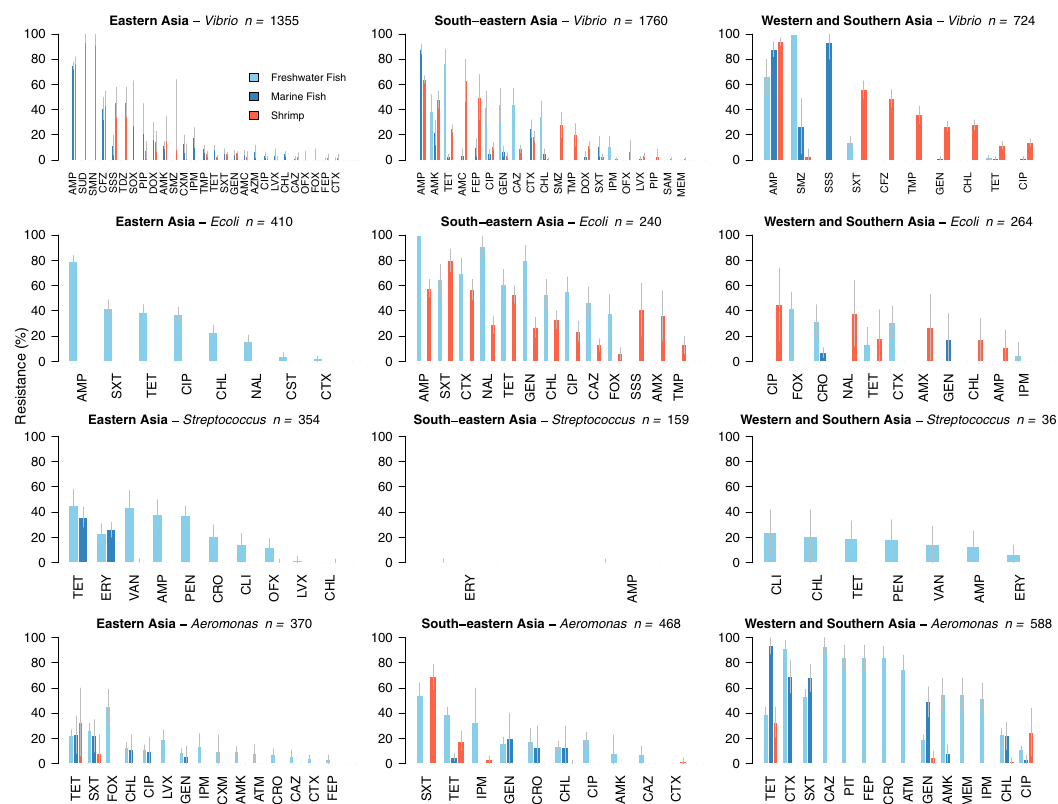
Fig. 2 Antimicrobial resistance in foodborne pathogens isolated from aquatic animals in Asia. Gray bars represent 95% proportion con fi dence intervals. Resistance is shown for pathogen-drug combinations recommended for susceptibility testing (Supplementary Table S1) and with 10 or more isolates tested. (For drug acronyms, see Supplementary Note 2).